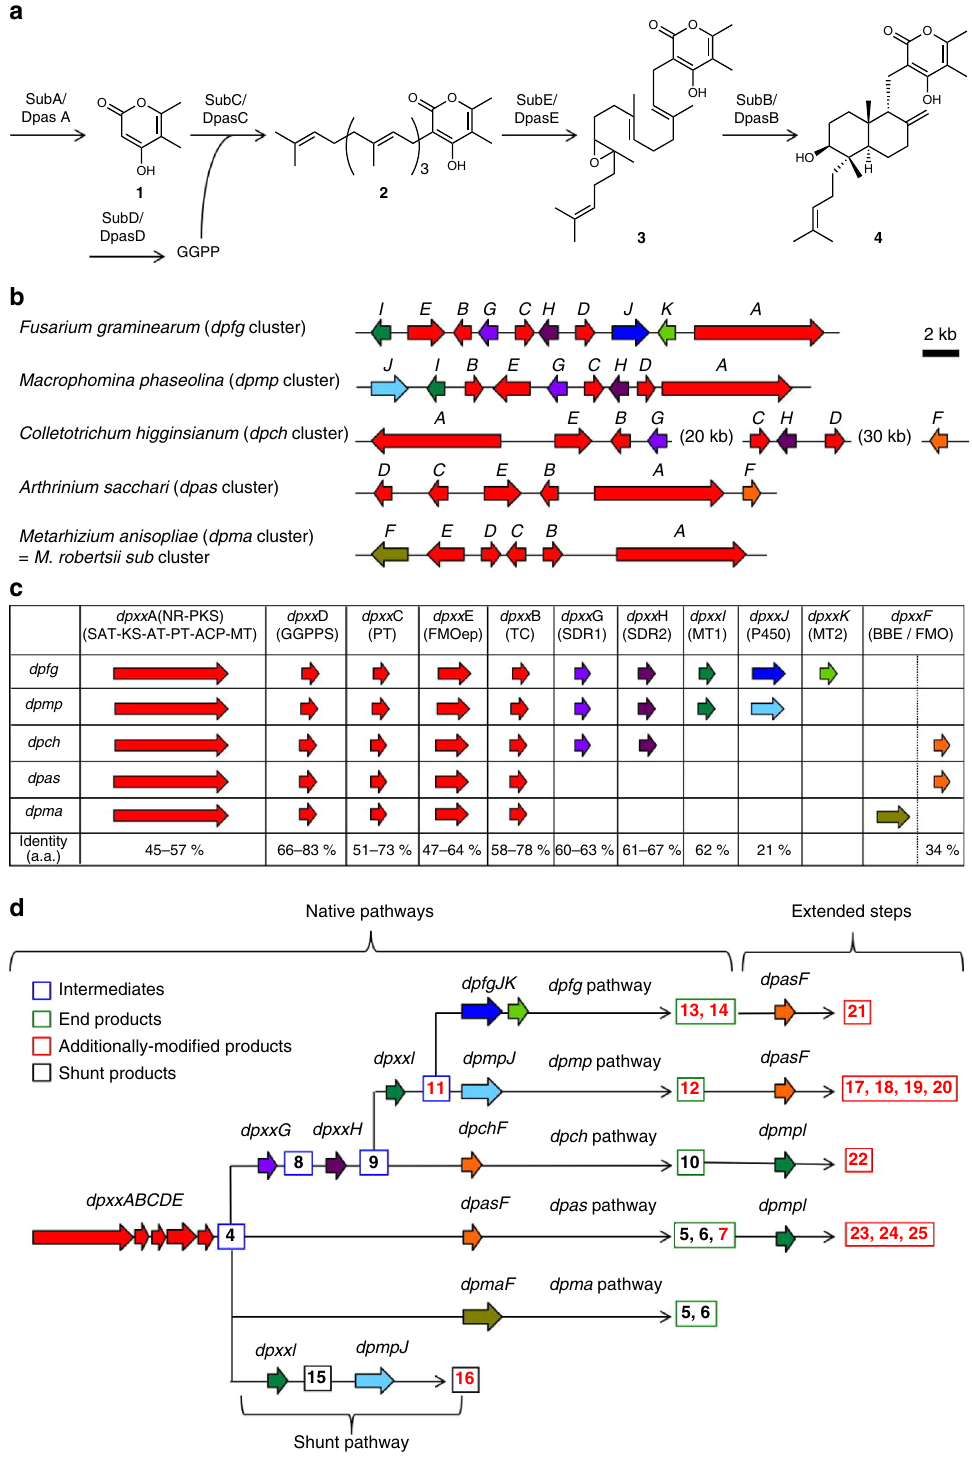
Fig. 3 Genome mining and design of DDP pathways. a Biosynthetic pathway for common intermediate 4 . b DDP biosynthetic gene clusters distributed in fi ve fungal genera. c Comparative analysis of each biosynthetic gene cluster. d Design of native pathways, extended steps and one shunt pathway heterologously reconstituted in this study and summary of products (red numbers show compounds that have not been reported.) produced through the DDP pathways (blue square, green square, red square and black square show intermediates, end products, additionally modi fi ed products and shunt products,